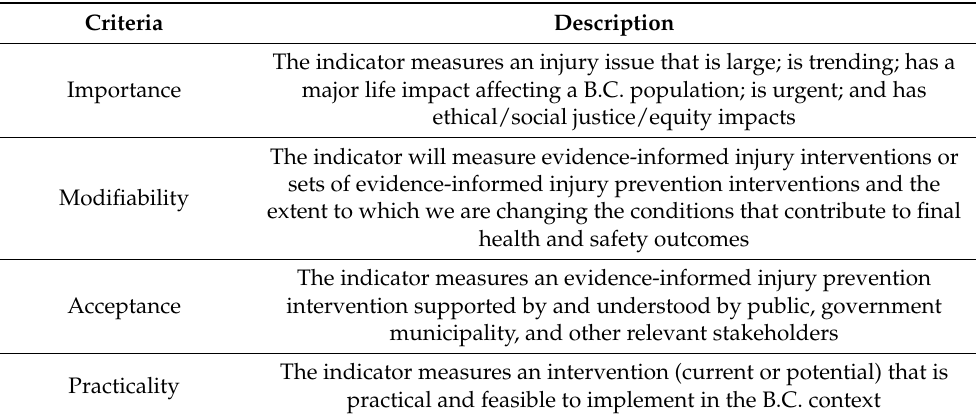
Table 1. BC injury indicator selection criteria used for road safety expert